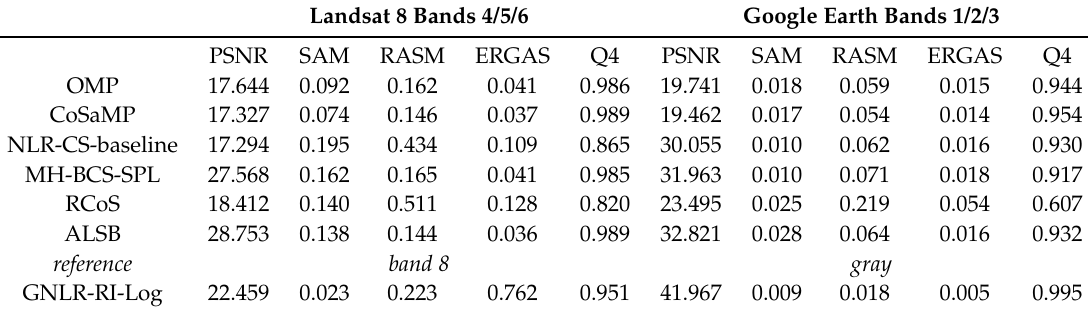
Table 4. Reconstruction evaluation of Landsat 8 Bands 4/5/6 with Band 8 as the reference and relative dimensionless global error; OMP, orthogonal matching pursuit; CoSaMP, compressive sampling matching pursuit; CS, compressed sensing; MH-BCS-SPL, multi-hypothesis predictions combined